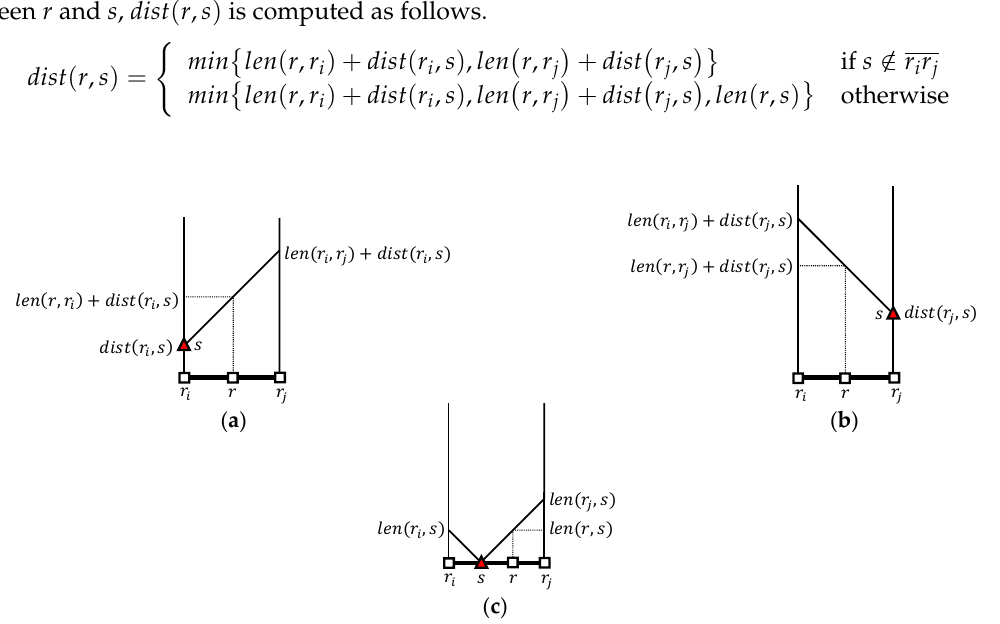
Figure 5b. If the inner object (cid:1871) is located in (cid:1870) (cid:3036) (cid:1870) (cid:3037) (i.e., (cid:1871) ∈ (cid:1870) (cid:3036) (cid:1870) (cid:3037) ), then the distance from (cid:1870) to (cid:1871) is